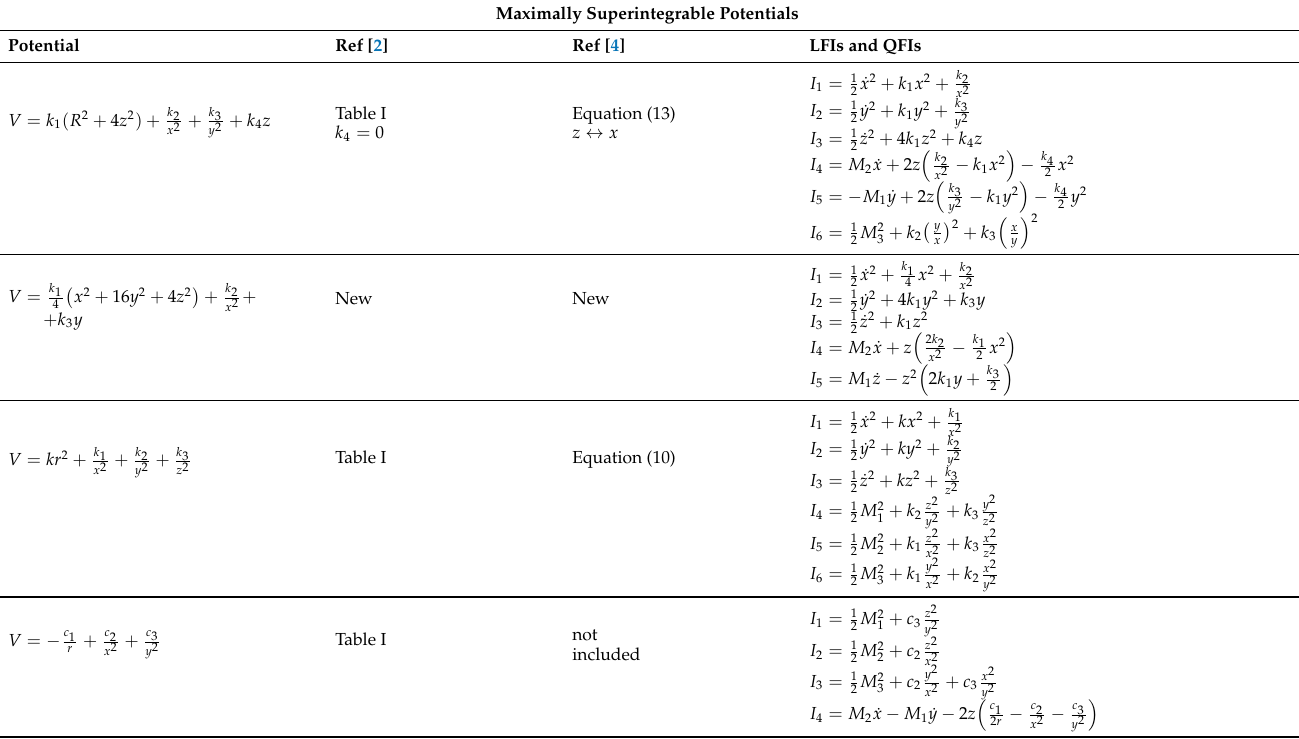
Table 7. Maximally superintegrable potentials V ( x , y , z ) in E 3 that admit QFIs of the type I ( 1,1 )